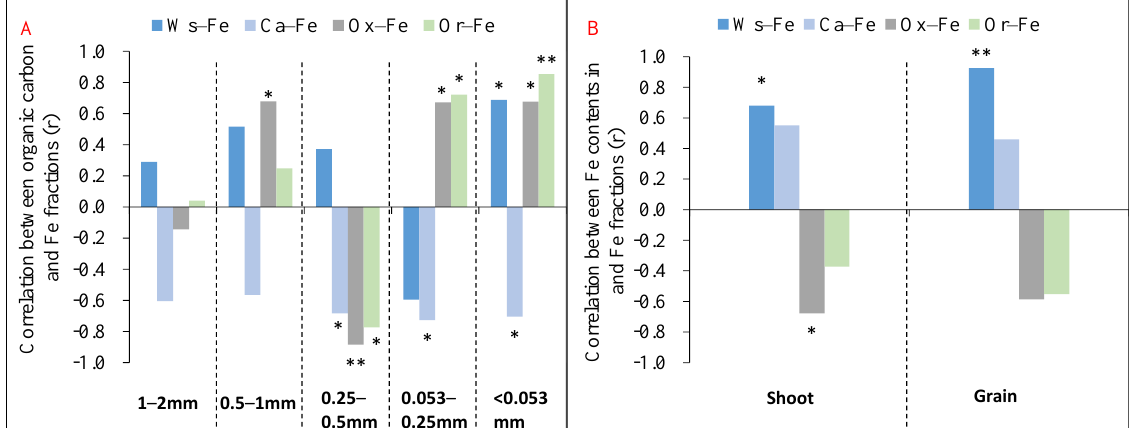
Figure 6. Correlations between indices. ( A ): Organic carbon and Fe fractions in soil aggregates. ( B ): Fe contents in plants and Fe fractions in soil. Ws – Fe: water – soluble Fe, Ca – Fe: carbonate bound Fe, Ox – Fe: iron – manganese – oxide – bound Fe, Or – Fe: organic – matter – bound Fe. * and ** denote statis- tically significant differences at p < 0.05 and p < 0.01, respectively, n = 9.